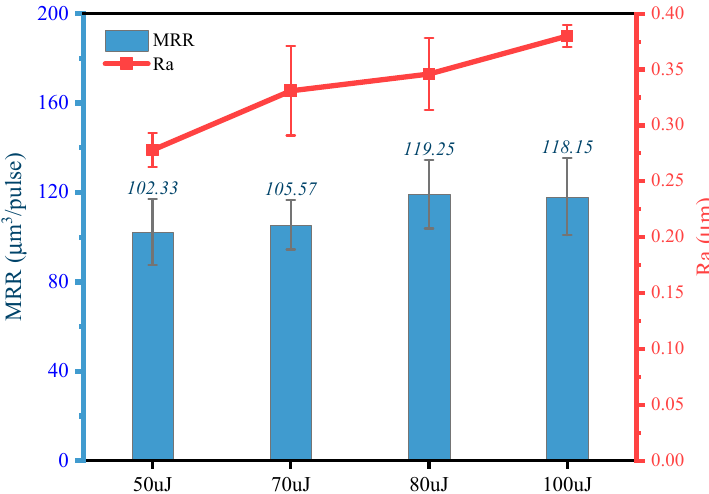
Figure 7. The surface roughness Ra and MRR vs. single pulse energies. The scanning speed is 1 mm/s, and the repetition rate is 1 kHz.